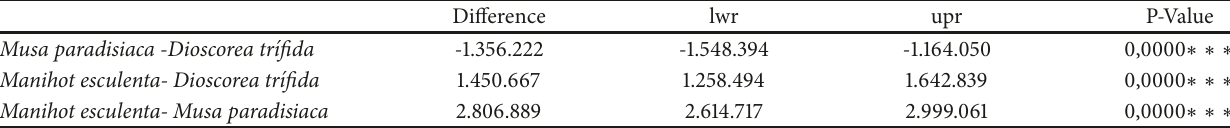
Table 4: Tukey test among raw